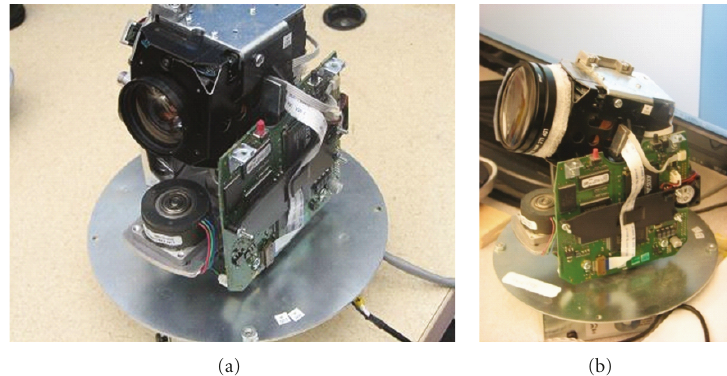
Figure 2: The Axis 233D network dome camera used in this work. (b) shows the camera after adding the necessary lenses for our work.